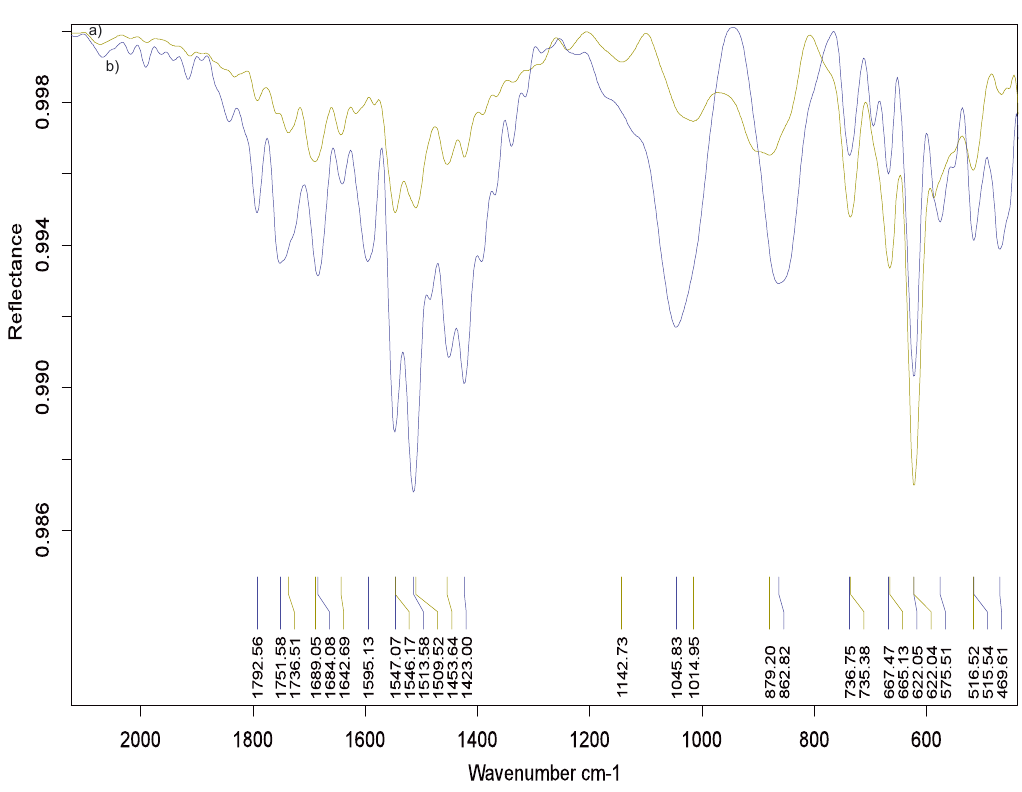
Figure 6. FTIR-VAR (45°) spectra comparison, region 600-2000, for a) Baltic amber (211____) and b) Romanian amber